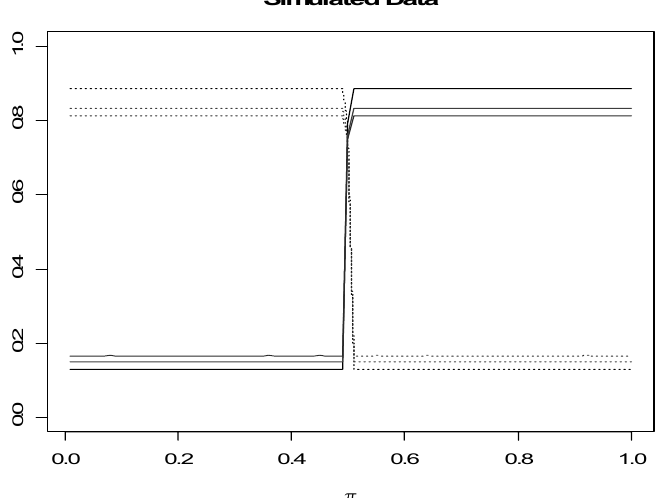
Figure 2 – Results of the optim function with L-BFGS-B minimization algorithm for one data gen- eration. Dotted lines are type I errors and solid lines represent the powers of each diagnostic test. T 1 = black lines; T 2 = red lines, and T 3 = blue lines. True illness incidence equals to